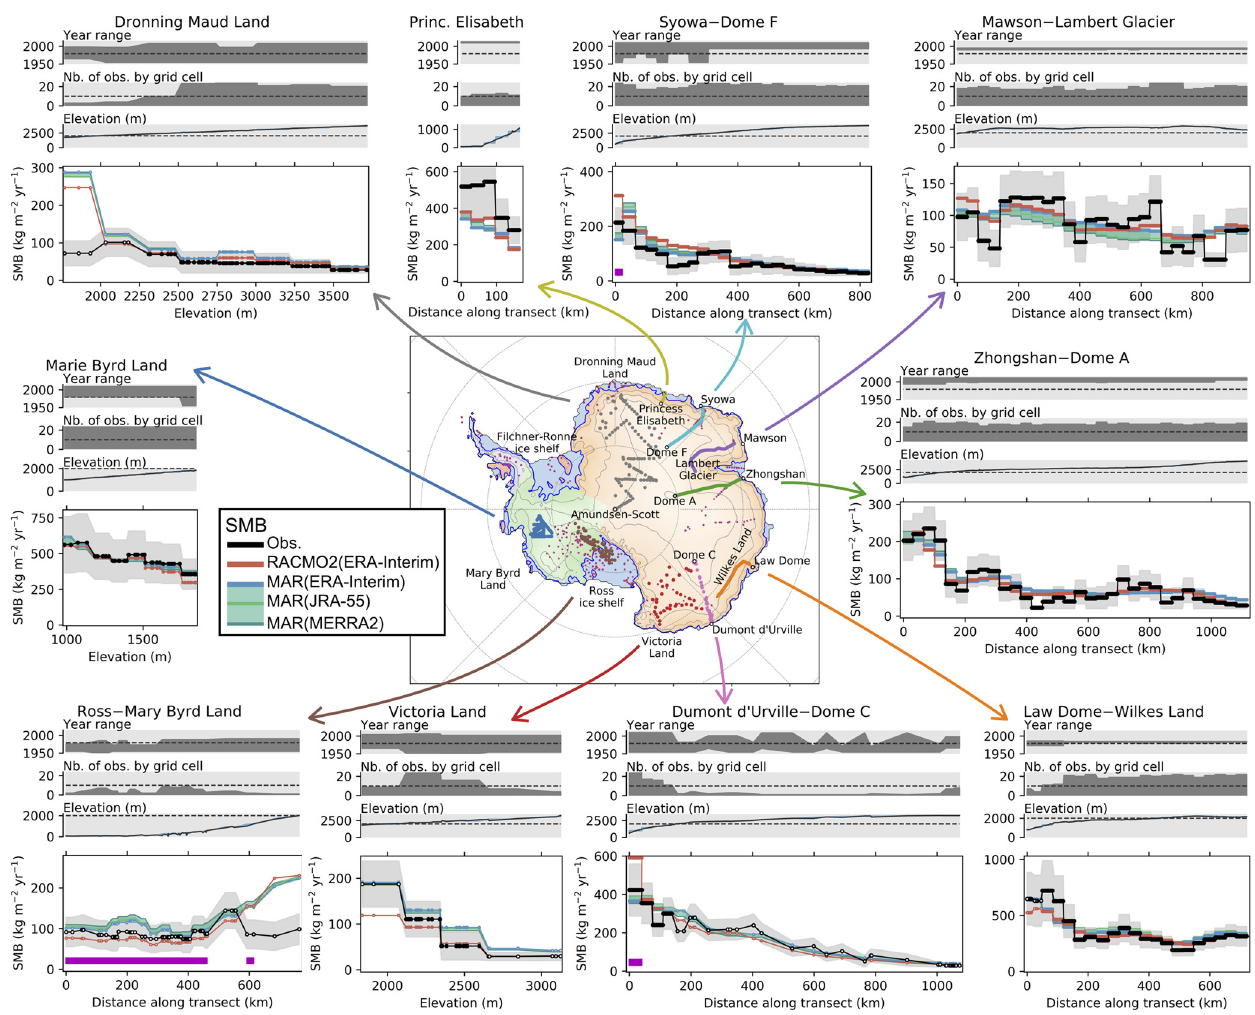
Figure 2. Modelled vs. observed SMB for sectors and transects as detailed in Table 1. RACMO2 outputs are bilinearly interpolated to the MAR grid. SMB values are first averaged on MAR grid cells (Sect. 2.2.2) then along a chosen grid direction (Fig. S2) or by elevation bins. Distance along the transect starts at the coast. Uncertainty of observed SMB (grey shaded area) is the standard deviation of observations contained in each grid cell (sub-grid variability), estimated as a function of the mean observed SMB (see Fig. S3). Despite SMB values corresponding to grid cell averages, we display one marker for each observation, with the x axis corresponding to the observation location along the transect or elevation. For observed SMB plots, markers with white faces are for bins containing fewer than 10 observations and black faces for bins containing more than 10 observations. Magenta bands mark grid cells in which more than 15% of precipitation sublimates in the katabatic layers according to Grazioli et al. (2017). The map shows the main Antarctic basins: Antarctic Peninsula in purple, West Antarctic ice sheet in green, and East Antarctic ice sheet in orange. Ice shelves are mapped in blue and grounded islands in red, and the blue line shows the location of the grounding